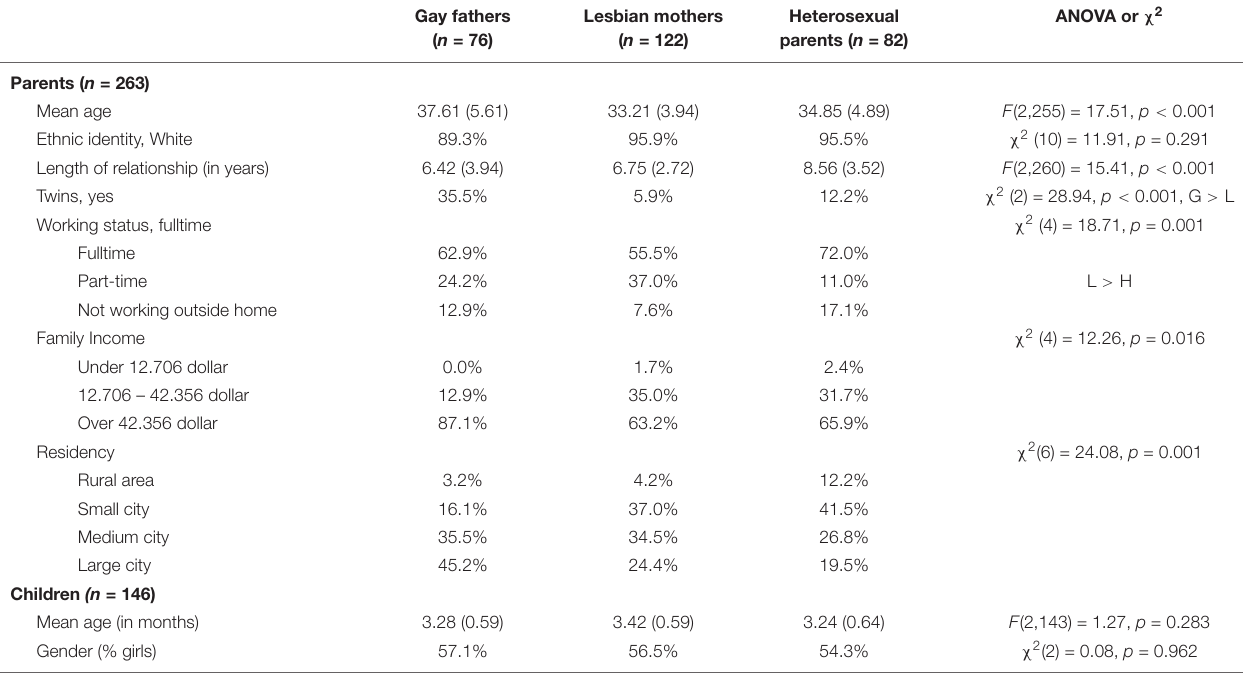
TABLE 1 | Demographic information about families headed by gay, lesbian, and heterosexual